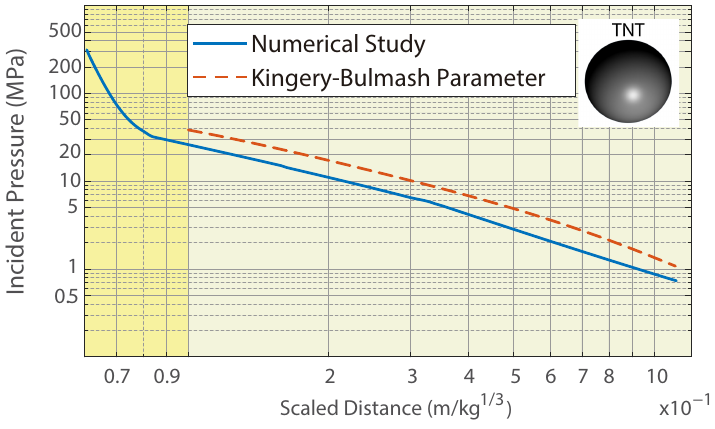
Figure 14. Comparison between Kingery–Bulmash blast parameters and numerical simulations for TNT spherical free-air